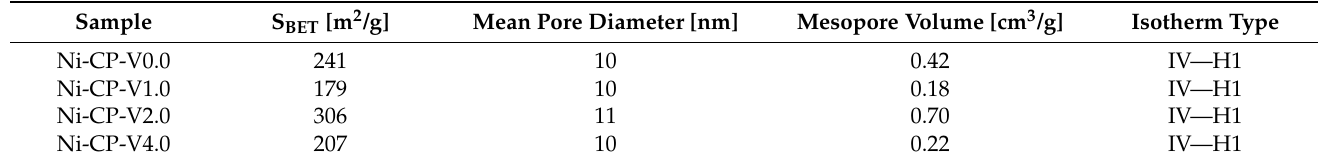
Table 2. Specific surface area, mean pore diameter, and volume of mesopores of the calcined catalysts.